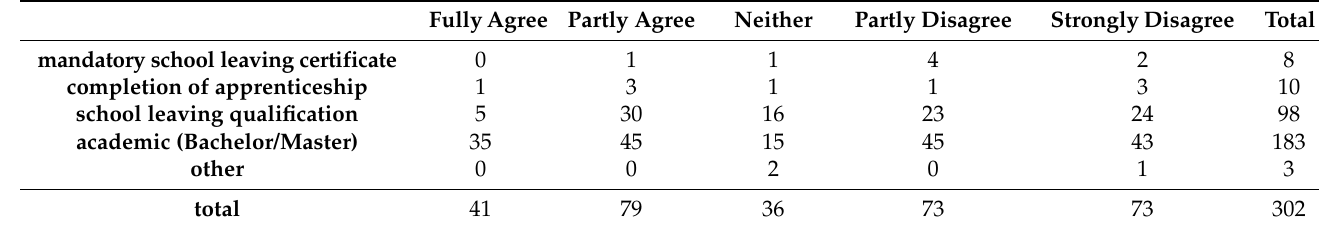
Table 2. School education and engagement in financial